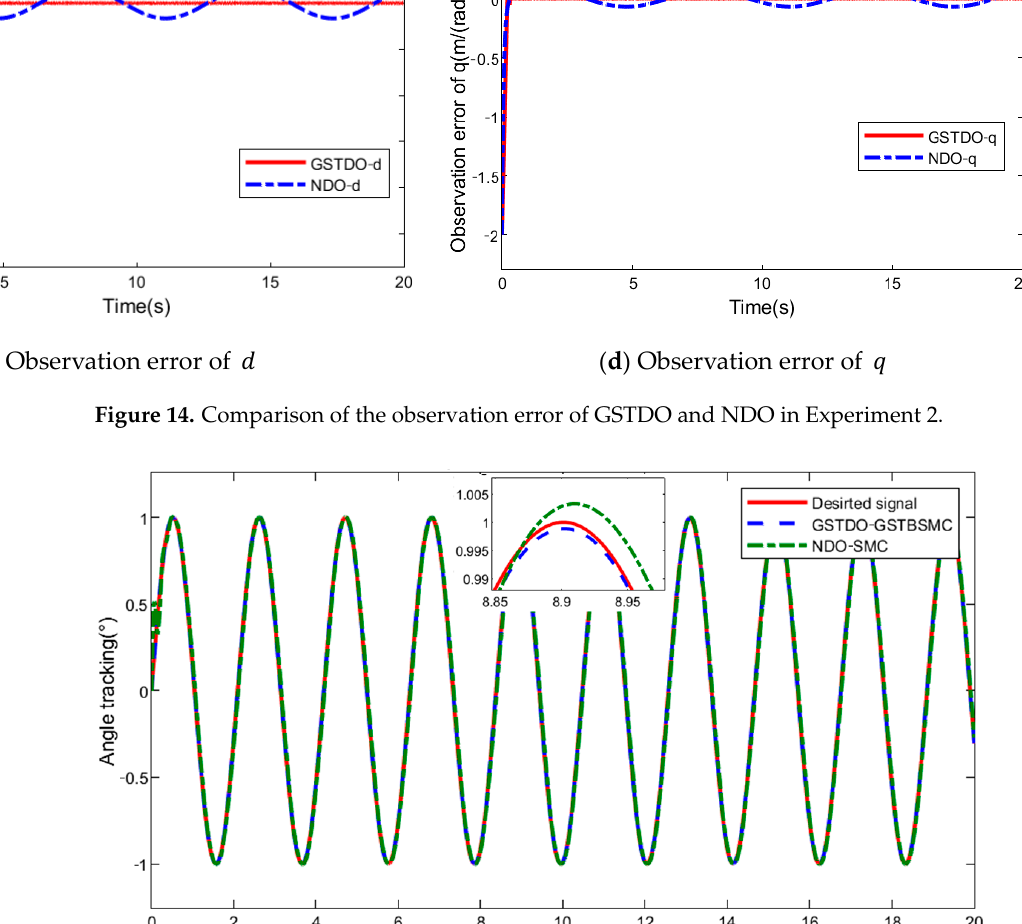
Figure 15. Comparison of the tracking results of GSTDO-GSTBSMC and NDO-SMC in Experiment 3.